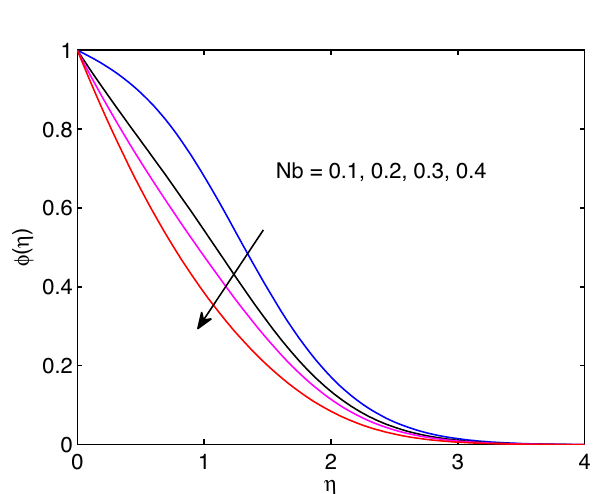
Figure 26. Brownian motion effects on volumetric concentration profiles.